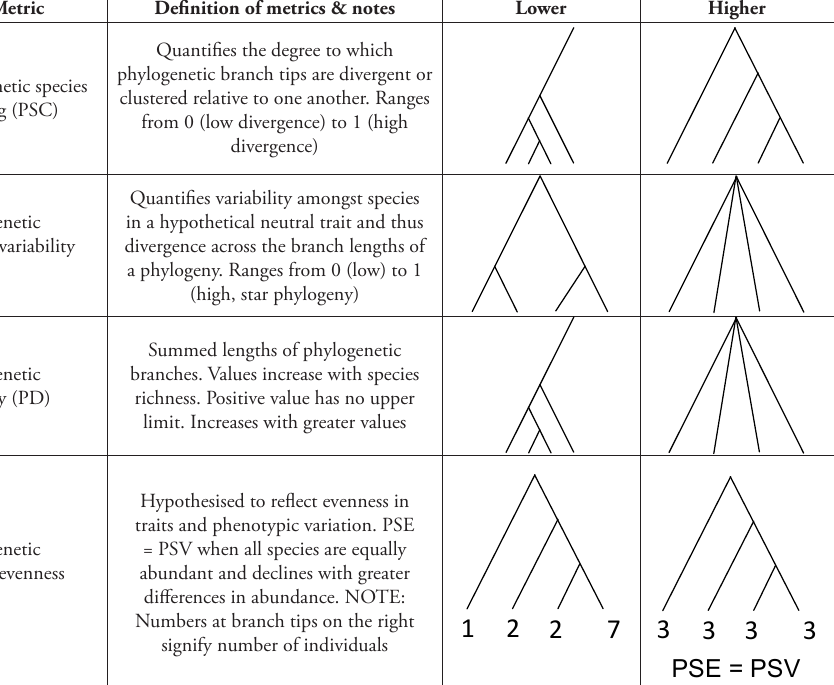
Table 1. Explanation of the four investigated metrics of evolutionary relatedness. PD is defined by Faith (1992) and PSE, PSV and PSC are defined by Helmus et al. (2007). Metric Definition of metrics & notes Lower Higher Phylogenetic species clustering (PSC) divergence) Phylogenetic species